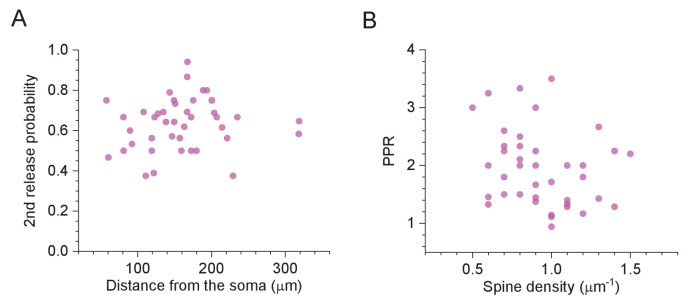
Selected features of excitatory synapses with respect to their dendritic location.(A) Average probability of the second release (paired-pulse stimuli 50 ms apart) plotted against distance to the soma; sample mean ± SEM: 0.633 ± 0.20 (n = 41). (B) Paired-pulse ratio (as P2/P1 in C) plotted against spine density along dendrites; sample mean ± SEM: 2.14 ± 0.17 (n = 41).